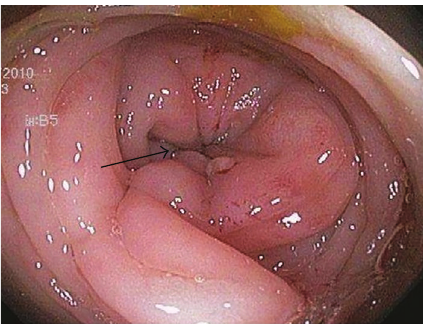
Figure 2: Fluoroscopic view of rectal stricture (yellow arrow).